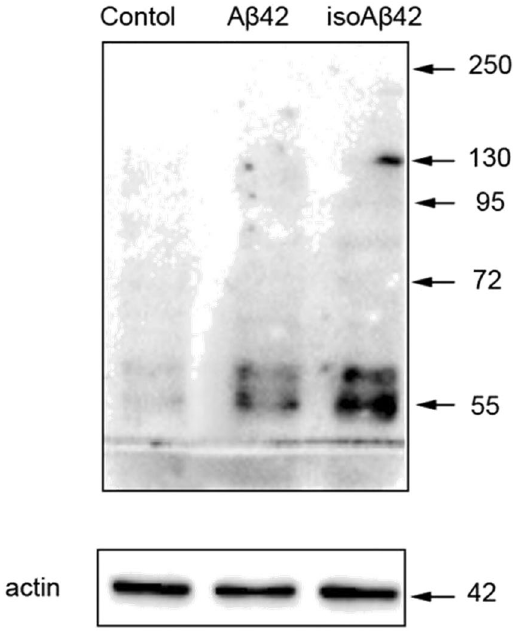
Figure 4. Effects of A β 42 and isoA β 42 (10 μ M, 6 h) treatment on the levels of phosphoserine-containing proteins. After incubation with the amyloid peptides, SH-SY5Y cells were lysed, the proteins were separated using 8% SDS-PAGE, and antibodies against phosphoserine were used to identify phosphoserine-containing protein